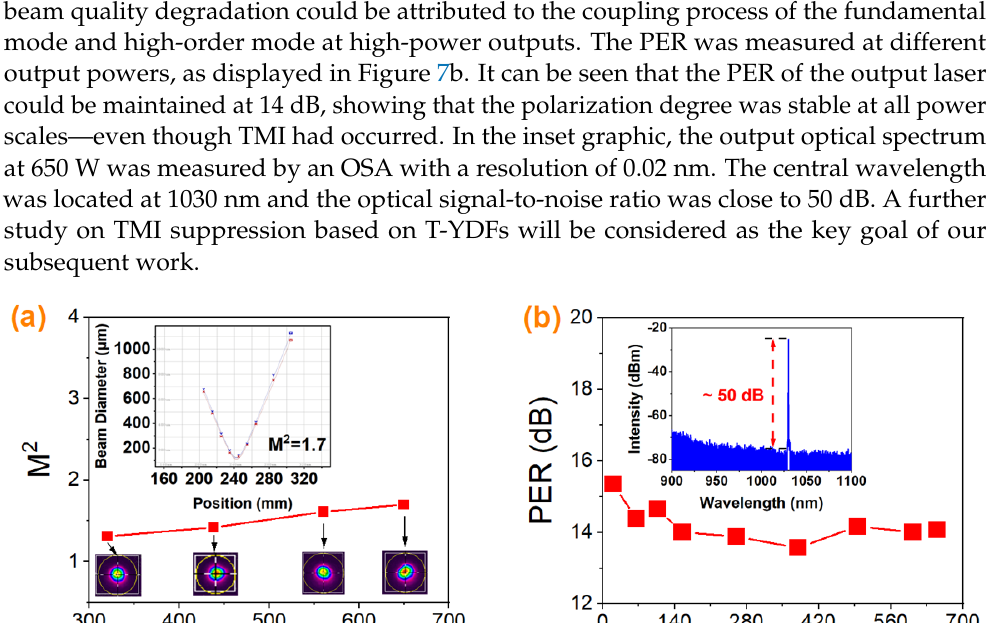
Figure 6. Measured beam quality and beam profile at different output powers. Inset: measured PER at different output power. ( a ) SFFA under single wavelength pumping. ( b ) SFFA under the hybrid pumping with a power ratio of 1:1.7.